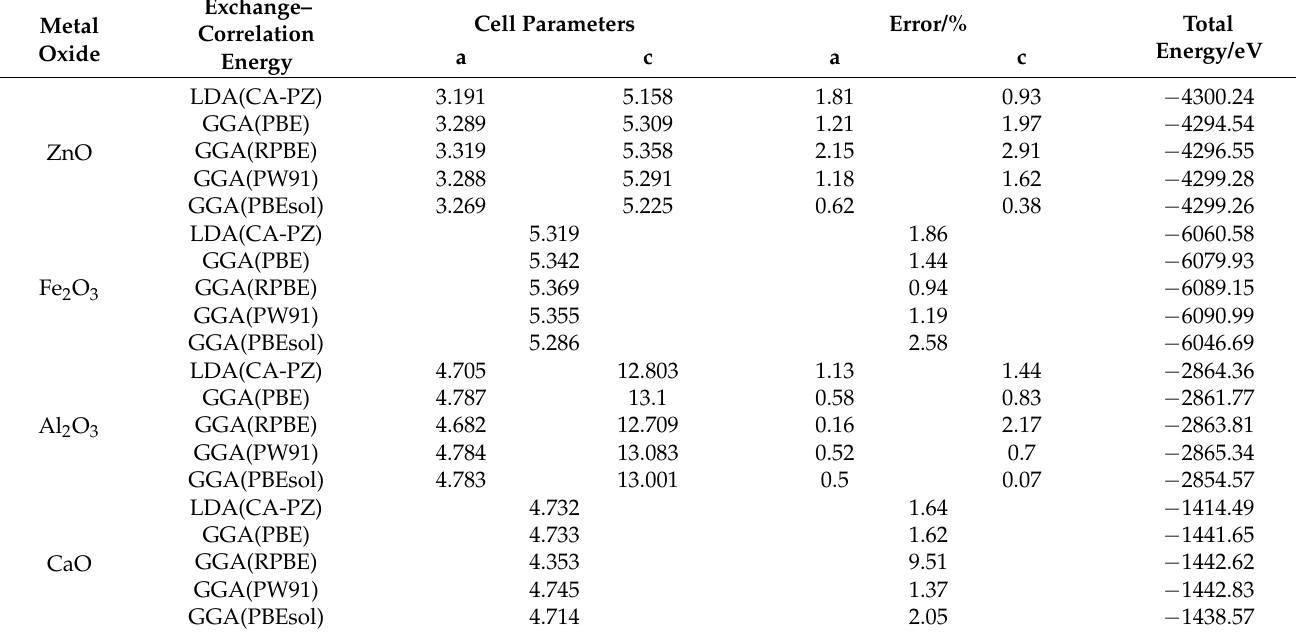
Table 2. Optimization results of exchange–correlation energy